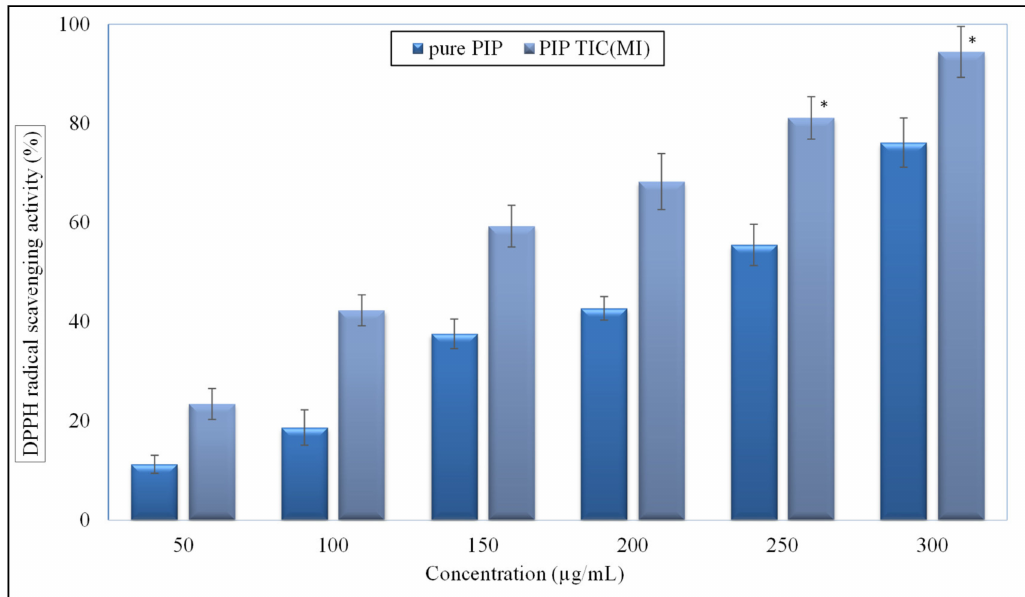
Figure 10. Comparative antioxidant activity profile of pure piperine and piperine ternary inclusion complex (PIP TIC (MI)). Values are presented as means ± SD with triplicates. The values having superscript (*) were significantly di ff erent ( p <